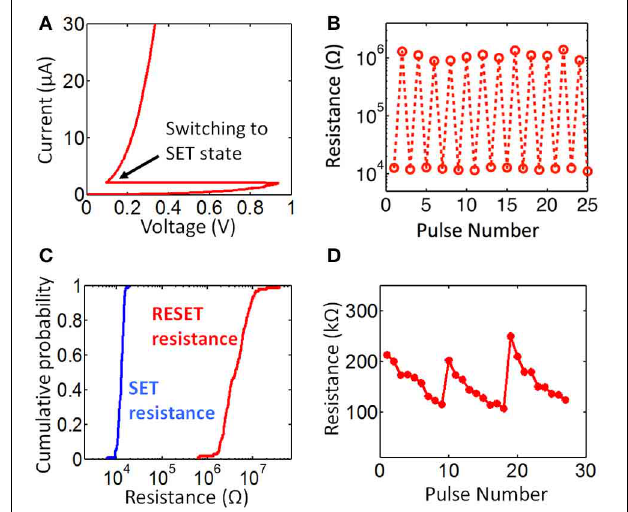
FIGURE 2 | Electrical characterization of memory cells. (A) shows the DC switching characteristics of a single memory cell arbitrarily selected from the array. Switching behavior can be observed when there is 2 µ A of current through the memory cell. Binary switching cycles are shown in (B) . SET pulse is applied at odd numbers of measurement (pulse #1, 3, ... ) and RESET pulse is applied at even numbers of measurement. The plot shows the measured resistance of the memory cell right after the programming pulse is applied. Array level binary resistance distribution is shown in (C) . Resistance window for binary operation is larger than 10k. Gradual resistance change in a single cell is shown in (D) . This plot is obtained by applying gradual SET pulses right after the cell is abruptly programmed to RESET state. The plot shows 3 cycles of this measurement. the more stable crystalline state, leaving it in the amorphous